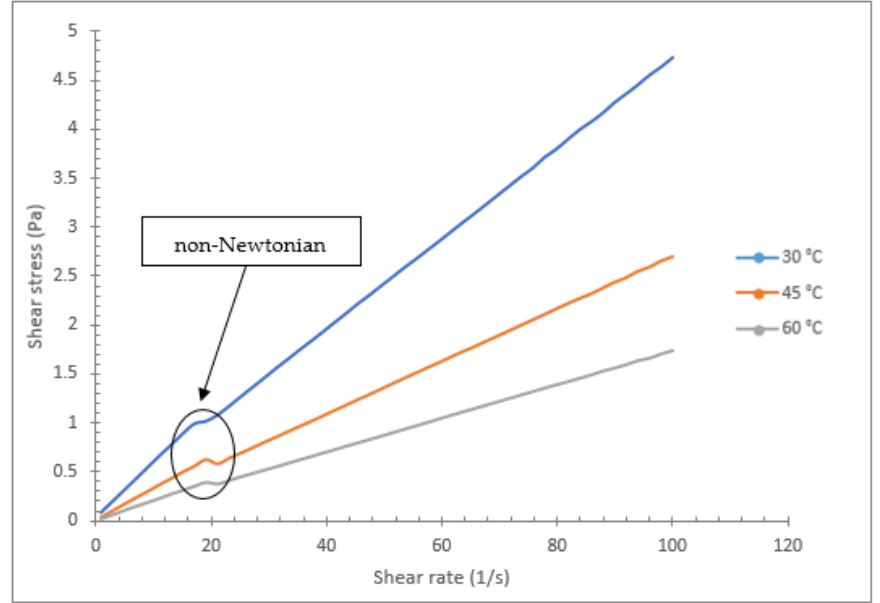
Figure 14. Rheological behaviour of palm oil/Al 2 O 3 -TiO 2 hybrid nanofluid (0.2%).